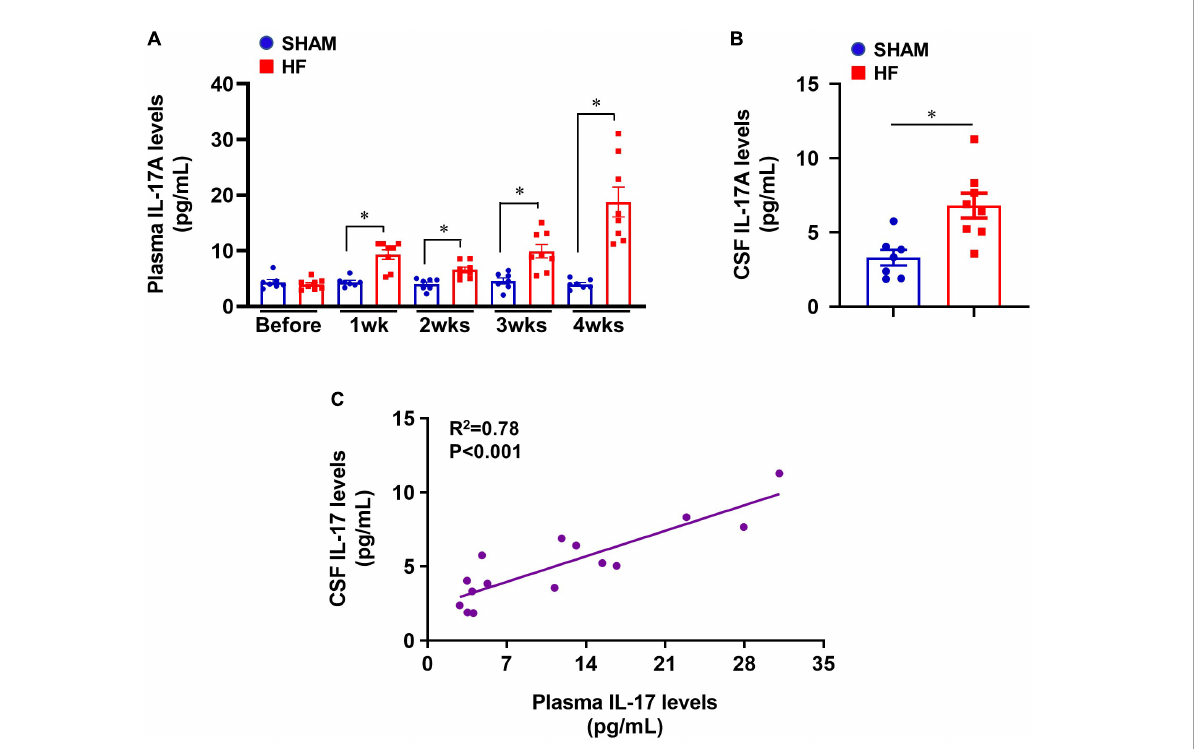
FIGURE1 (A) Plasma IL-17A levels in SHAM and HF rats at 1-4 weeks after CL. (B) CSF IL-17A levels in SHAM and HF rats 4 weeks after CL. (C) Correlation between plasma IL-17A levels and CSF IL-17A levels in SHAM and HF rats 4 weeks after CL. CSF: cerebrospinal fluid. Data are mean ± SEM ( n = 7-8 for each group); * p <